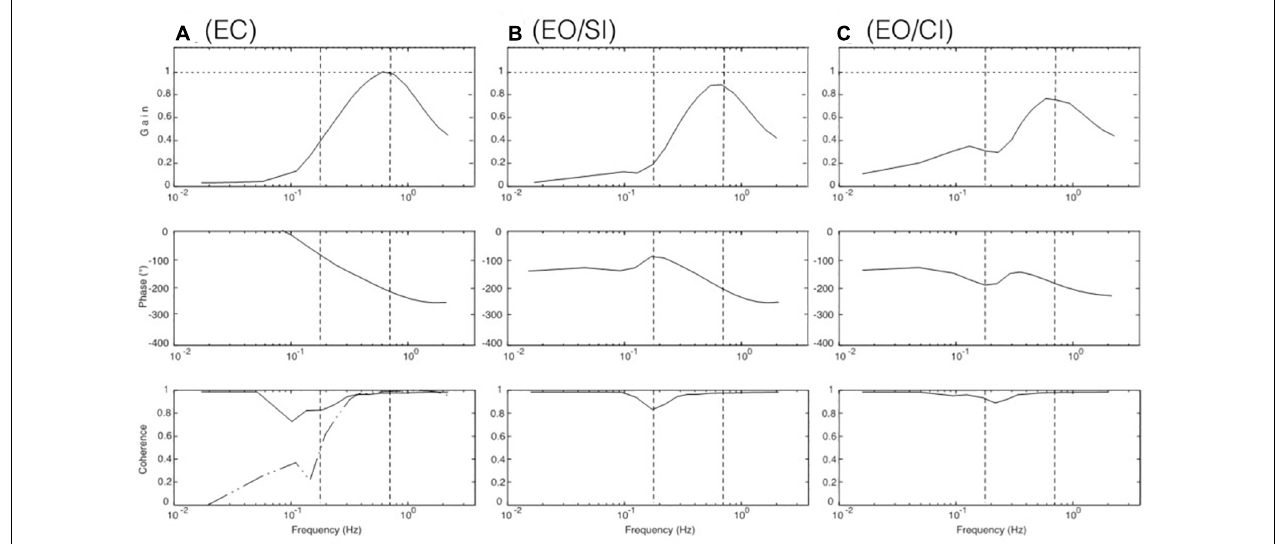
FIGURE 5 | Model simulation results for COM balancing without vision ( A ; EC), with visual position information available ( B ; EO/SI), and with both visual position and velocity information available ( C ; EO/CI). Note that these results reproduce the main response features obtained in the human experiments (compare Figures 3A–C ). The dash-dot coherence curve in (A) shows result of adding low-frequency noise to the control. It suggests that noise may explain to a large extent the difference in coherence seen between the simulations and the human data in the low-frequency